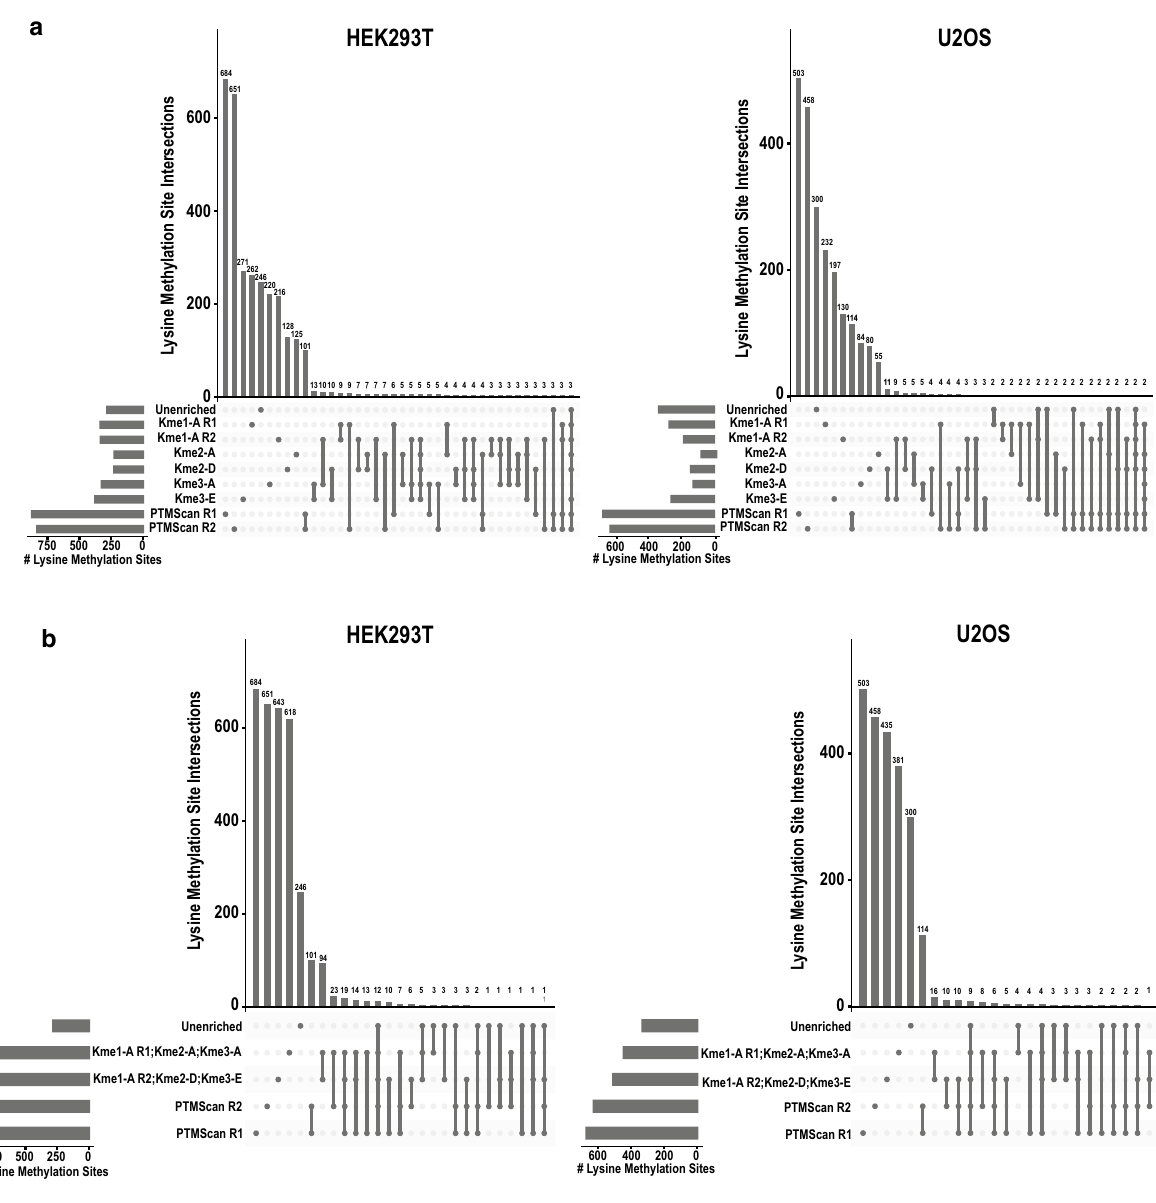
Figure 4. Lysine methylation enrichment impacts which lysine methyl sites are detected by mass spectrometry. ( a ) Upset plots showing lysine methylation sites identified using each enrichment strategy from HEK293T or U2OS lysates, as indicated. Horizontal bars on the left display the total number of lysine methylation sites identified by each enrichment strategy. Vertical lines connecting points represent overlap of identified sites. ( b ) Upset plots showing lysine methylation sites identified in unenriched samples, samples subjected to sequential antibody enrichment, or samples enriched with PTMScan kits from HEK293T or U2OS lysates, as indicated. R1 and R2 are